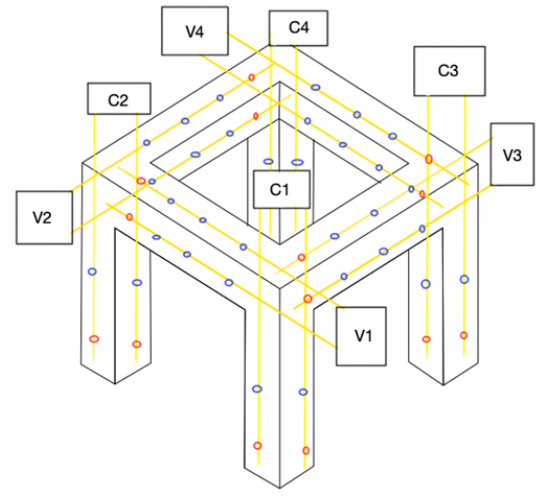
Figure 2. Schematic location of fiber optic lines with sensors. Blue dots represent strain sensors and red dots temperature sensors.